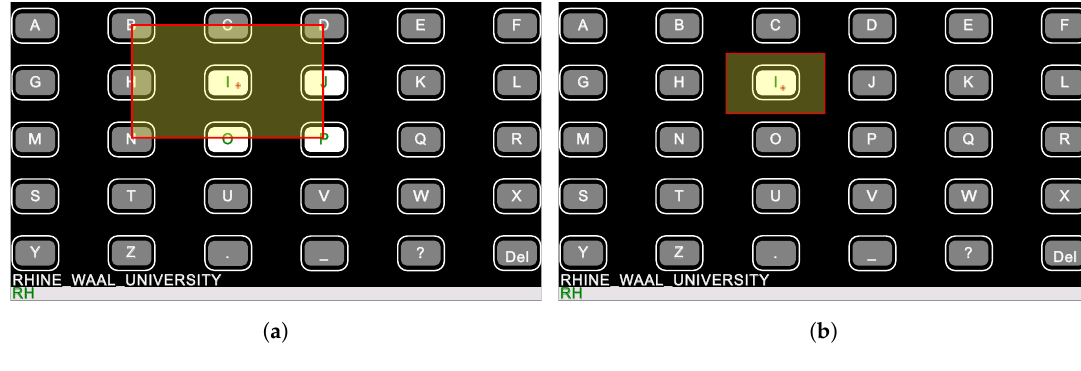
Figure 4. Selecting the letter “I” with the Hybrid ( a ) and the Eyegaze speller interface ( b ). In the Hybrid system the eye tracking data was used for initial rough selection. If the traced eye coordinates lay within the yellow rectangle (11 cm × 19 cm), the box containing the desired letter started flickering. If eye tracking was used alone, the traced coordinates needed to be much more precise (5.5 cm × 9.5 cm rectangle on the right hand side). The eye tracking software calculated the user’s eye gaze coordinates with an average accuracy of around 0.5 ◦ to 1 ◦ of visual angle depending on the calibration, which corresponded to an on-screen average error of 0.5 to 1 cm, assuming the user sat approximately 60 cm away from the